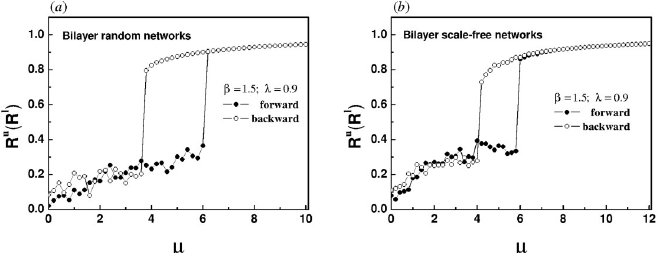
Fig 11. The panels show the evolution of order parameter of the upper layer with the increase of intra-layer coupling strength for different network topologies, (a) both the upper and lower layers are random networks, (b) both the upper and lower layers are scale-free networks. The inter-layer coupling strength λ is set to 0.9. The natural frequency of each oscillator in the upper layer is randomly selected in the interval [-1, 1], and the natural frequency of oscillators with the same label in the lower layer changes synchronously. Because the upper and lower networks belong to the same type, the evolution of order parameters is almost the same. In order to avoid repetition, the evolution law of order parameter of the lower layer is